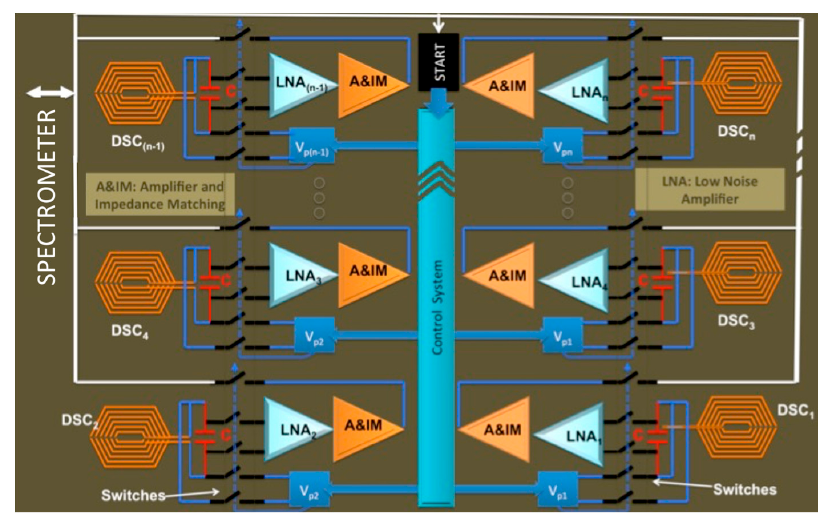
Figure 4. High throughput CMOS based Active NMR.